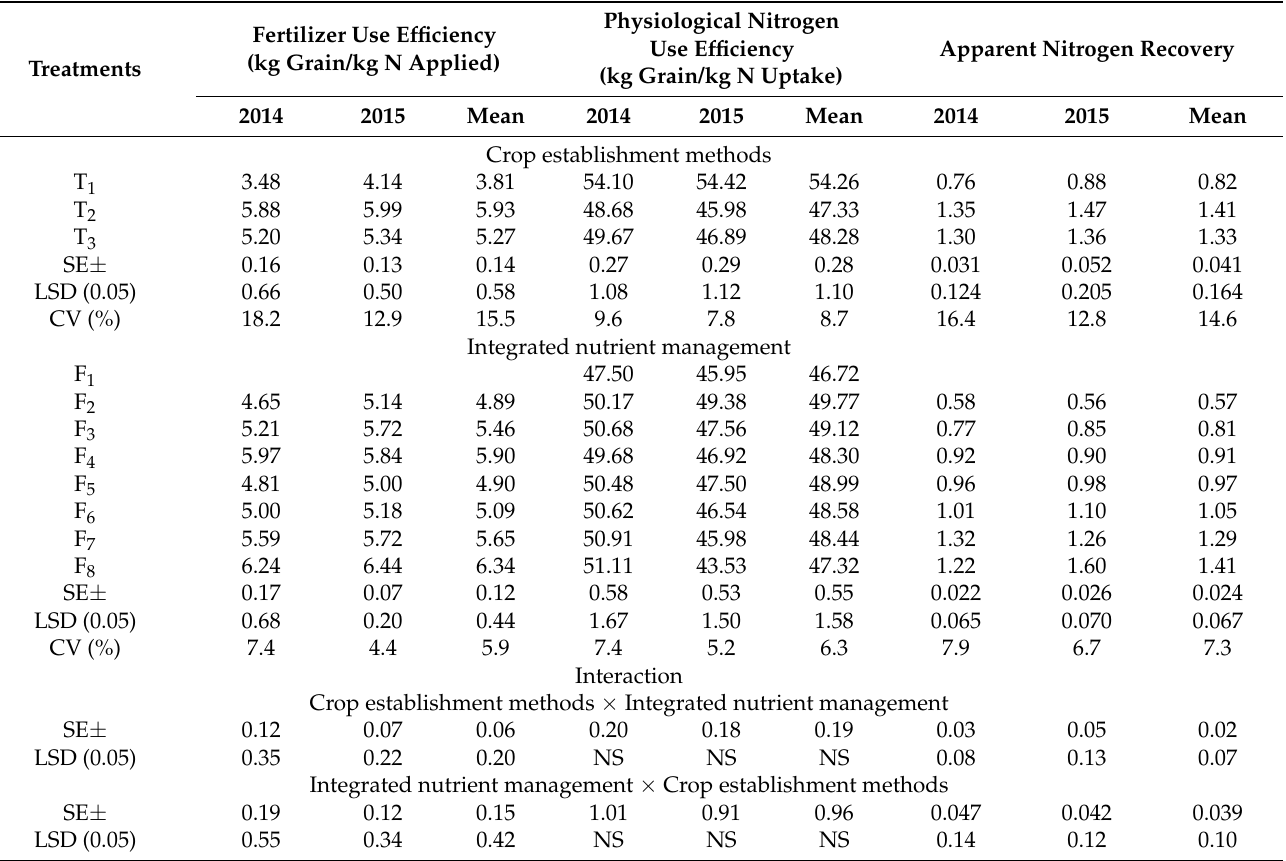
Table 4. Crop establishment methods and integrated nutrient management influence the nutrient use efficiency, partial factor productivity of nutrients, value cost ratio, and apparent nitrogen recovery in